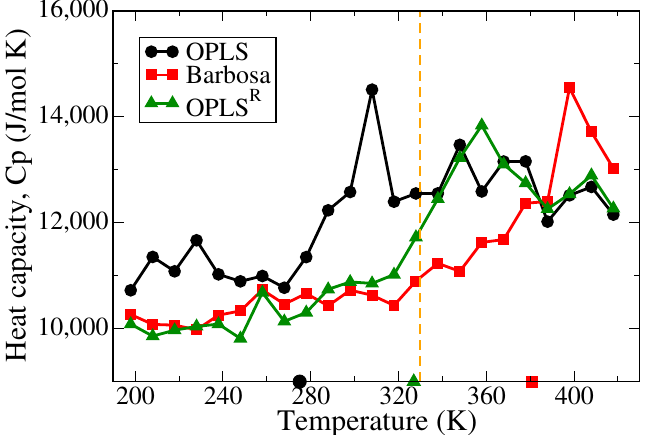
Figure 3. Heat capacity profiles of pure PEO systems in three different force fields as functions of temperature. The profile with black circles is the result of the OPLS model, and the ones with red squares and green triangles are the results of the Barbosa and the OPLS R models, respectively. The orange dashed line denotes the experimental Tm value from